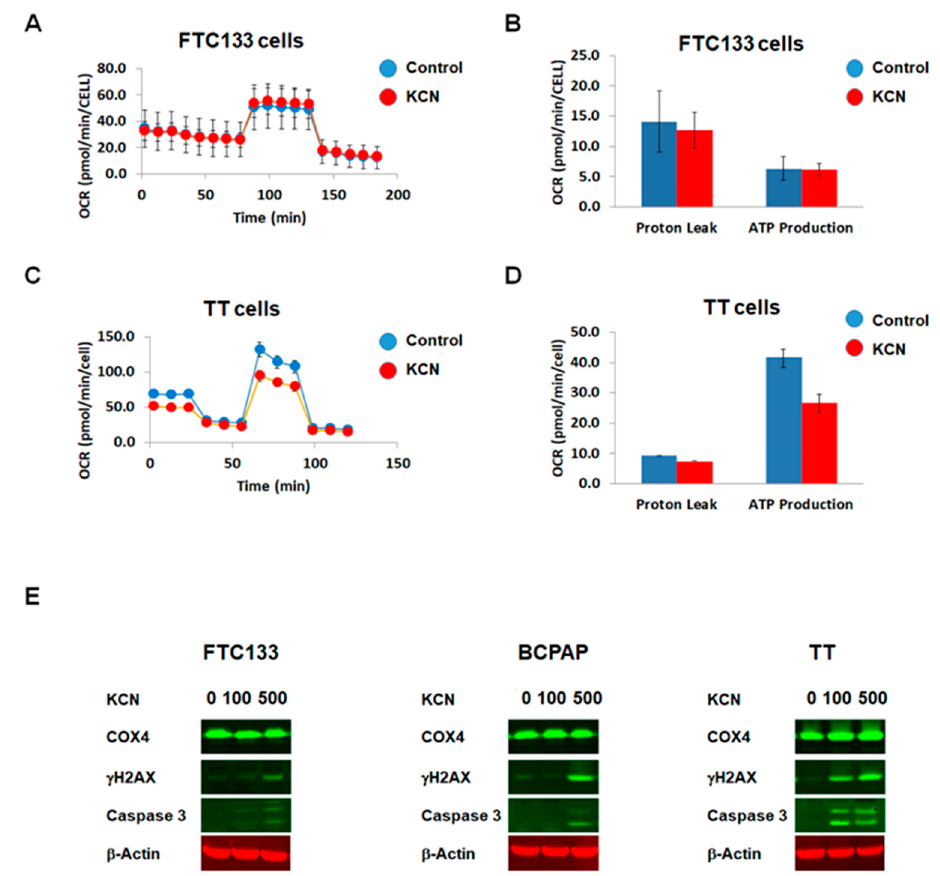
Figure 6. The effects of a pharmacological inhibitor of COX on thyroid cancer cells. ( A ) Seahorse Mitostress Assay demonstrates that treatment with KCN (100 μ M for 24 h) had no effects on the oxygen consumption rate in FTC133 cells. ( B ) Treatment with KCN had no effects on ATP production in FTC133 cells. ( C ) Seahorse Mitostress Assay shows a decrease in oxygen consumption rate in TT cells that were treated with KCN (100 μ M for 24 h). ( D ) The ATP production is lower in KCN-treated TT cells as compared to control. ( E ) Treatment with KCN induced DNA damage and caspase 3 cleavage in TT cells in dose dependent manner.